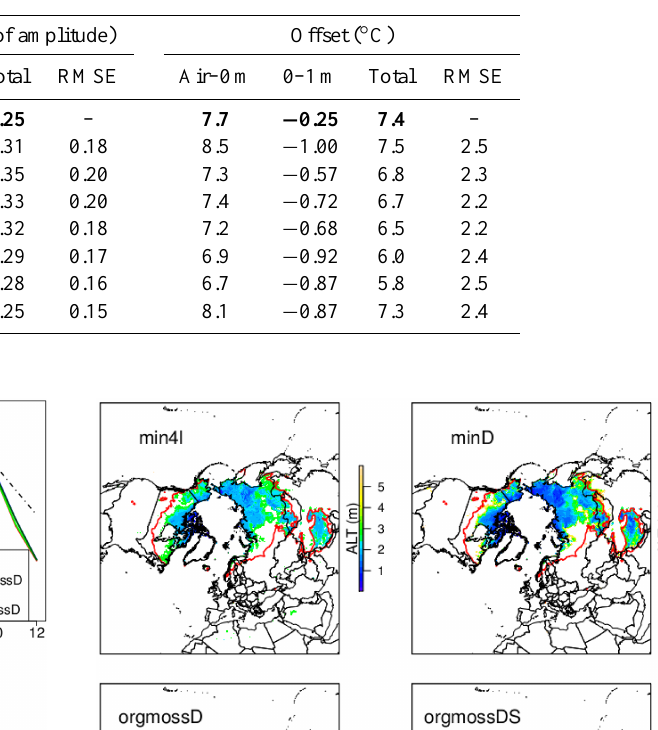
Table 3. The attenuation of the annual cycle and the thermal offset in the JULES simulations, between the air and the top of the soil, and the top of the soil and 1m depth, calculated as in Koven et al. (2012). This includes IPY-TSP and Russian data for cold sites. The RMSE (root mean squared error) values are based on the mean value of the metric at each site and thus give an indication of how well the variability between sites is captured. The bold numbers mark the observations as distinct from simulated values.